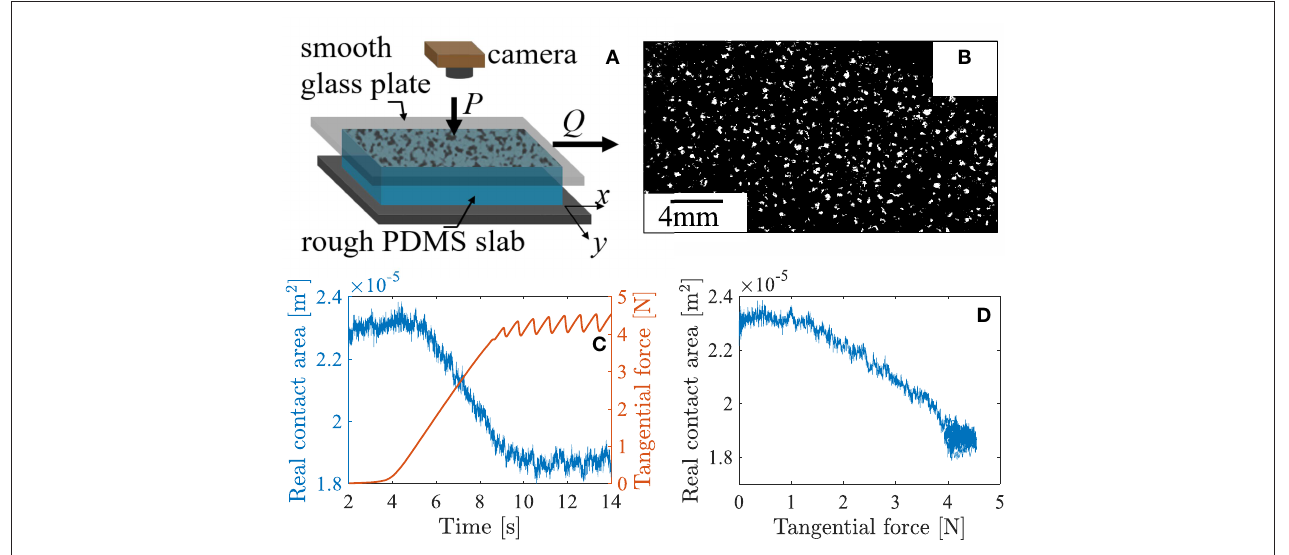
FIGURE 1 | Experiments that our model attempts to reproduce. (A) Sketch of the experimental setup. (B) Typical segmented image of the interface showing individual microcontacts in white, for P = 6.40 N. (C) Concurrent time evolutions of the tangential force Q (red) and the area of real contact (blue), for P = 3.10 N. (D) Area of real contact as a function of the tangential force, for the same data as in (C)